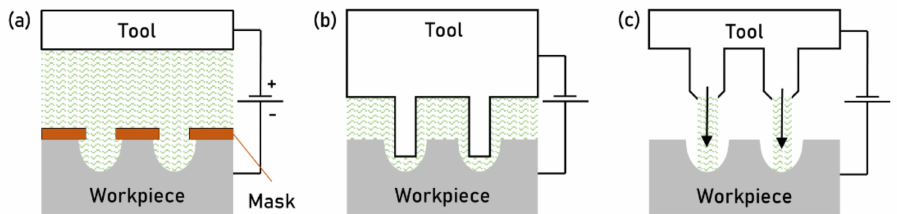
Figure 6. ( a ) Through mask electrochemical machining ( b ) maskless electro chemical machining ( c ) jet